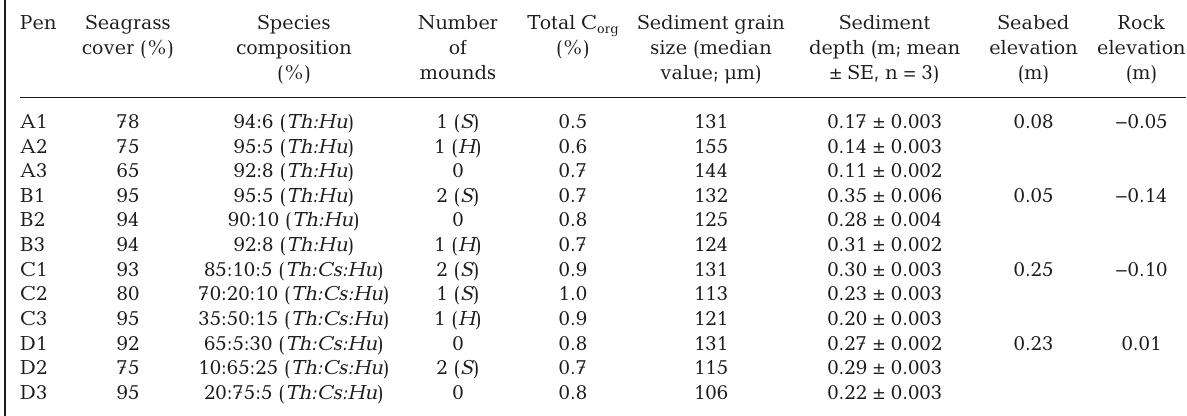
Table 1. Descriptor variables characterising the environmental conditions of each individual aquaculture pen. C org : organic carbon. Th : Thalassia hemprichii ; Cs : Cymodocea serrulata ; Hu : Halodule uninervis ; S : shrimp mound; H : holothurian mound.